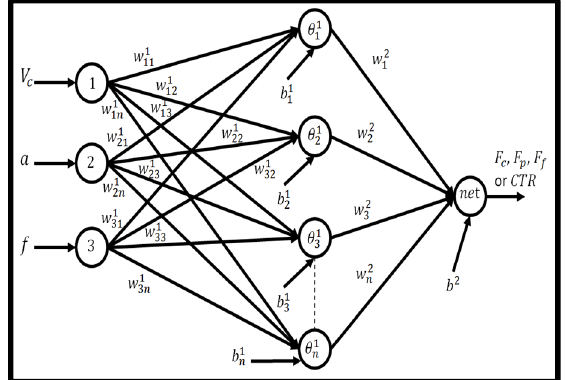
Fig. 3. The proposed neural network model.